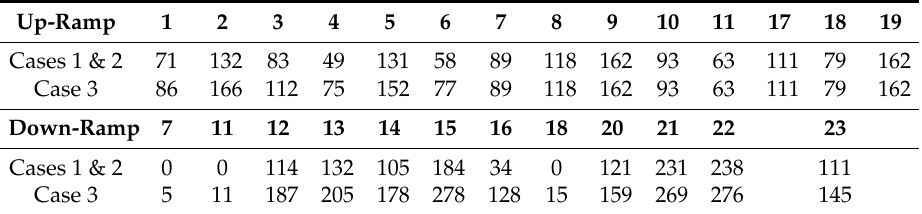
Table 4. Upward and downward system RC